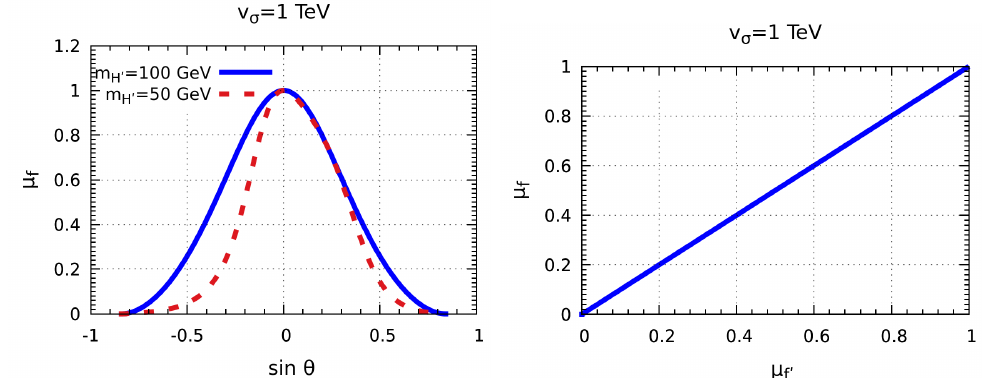
Figure 6 . Left panel : the signal strength parameter µ f versus sin θ for light Higgs masses, m H 0 = 100 GeV and 50 GeV. Note that for our model the rate never exceeds the SM prediction which is 1. Right panel : correlation between µ and µ , where f 6 = f 0 . The straight line reflects the fact f f 0 that, once we fix the two Higgs masses, there is essentially only one free parameter left, the mixing angle θ